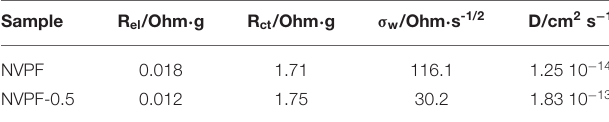
TABLE 2 | Resistance values and apparent diffusion coefficients calculated from the impedance spectra of Na 3 V 2 (PO 4 ) 2 F 3 electrodes after 1 cycle at 0.5C.